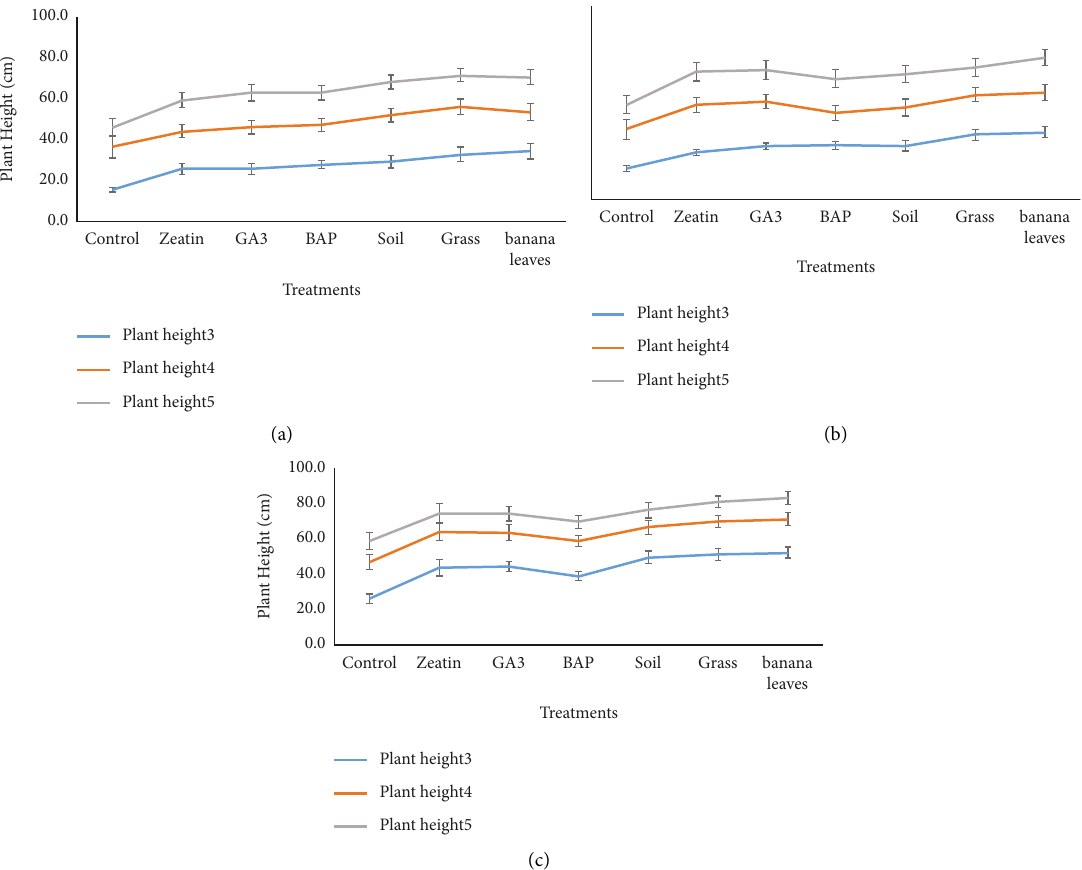
Figure 2: Means and standard error bars of potato plant height as affected by natural materials (soil, banana leaves, and grass) and plant growth regulators (GA3, BAP, and Zeatin). Plant height 3, 4, and 5 weeks after planting. (a) Dutch Robijn; (b) Kenya Karibu; and (c) Shangi